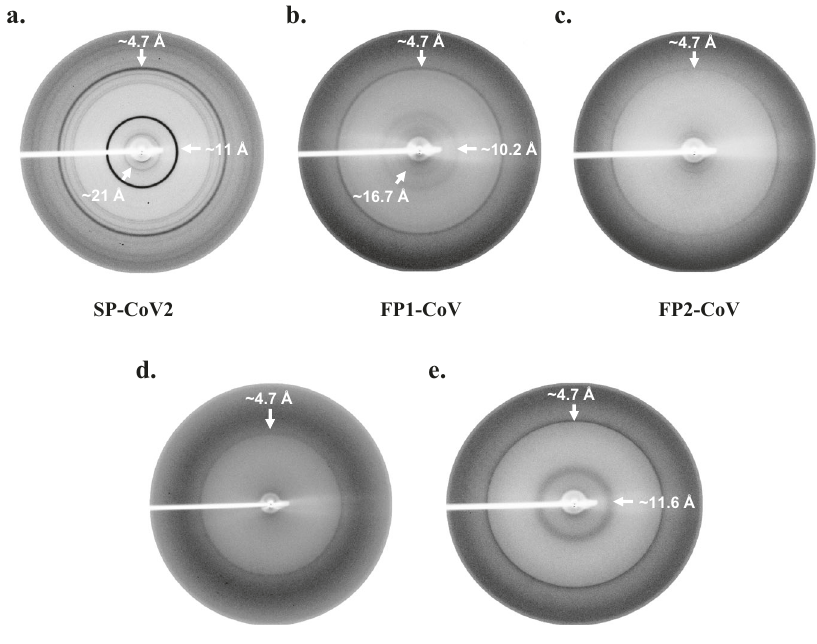
Fig. 9 | X-ray diffraction pattern of un-oriented amyloid aggregates of SARS- CoV and SARS-CoV-2 peptides. X-ray diffraction data for peptides a SP-CoV2, b FP1-CoV, c FP2-CoV, d FP1-CoV2, and e NSP6-p were collected at room tem- perature as described in the methods section. Prominent X-ray diffraction rings